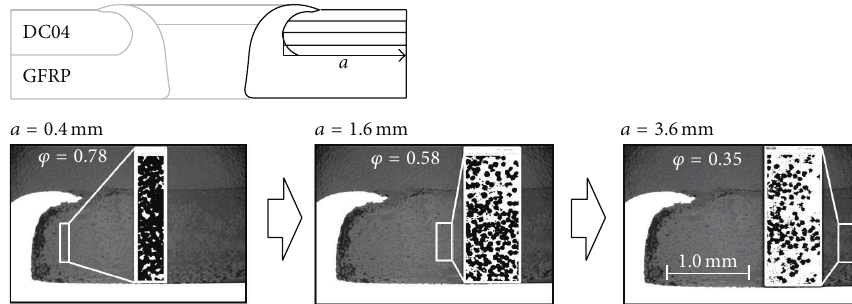
Figure 14: Micro section of a DC04/GFRP joint and analysis of the fiber volume.